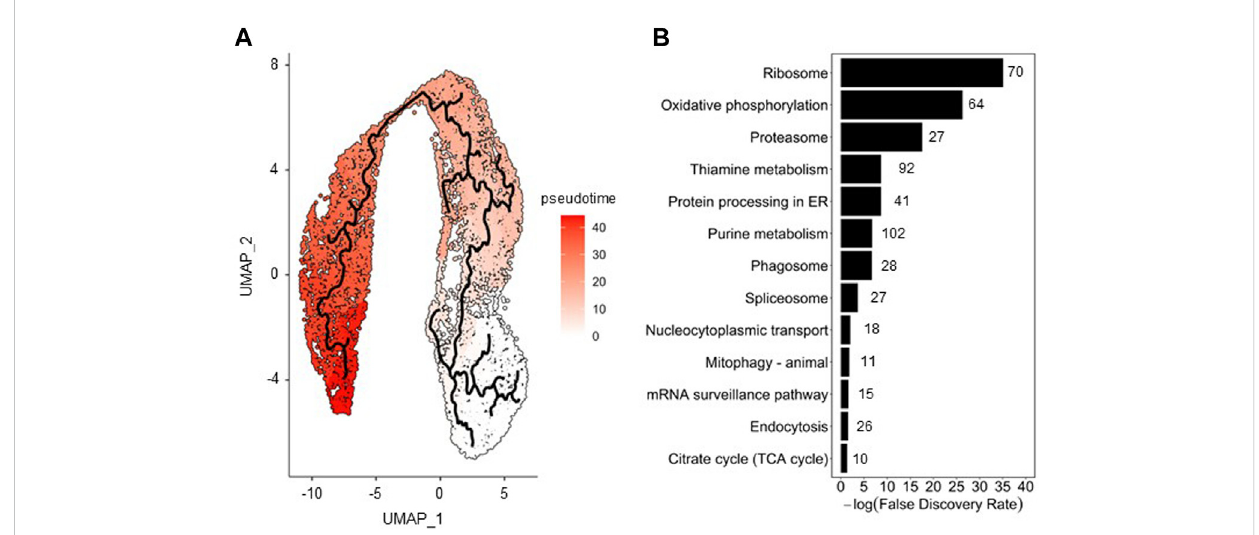
FIGURE 4 Pseudotimeanalysisofinsectcellsalonginfection. (A) Trajectoryanalysisonmergedcelldataset(0,8,and22hpi);acolorgradientscalewasusedto visualize the pseudotime. (B) Pathway enrichment analysis performed with genes identi fi ed as the most changing in function of pseudotime using the Fisher ’ s exact test; the number of genes involved and found in the enrichment analysis are shown next to the